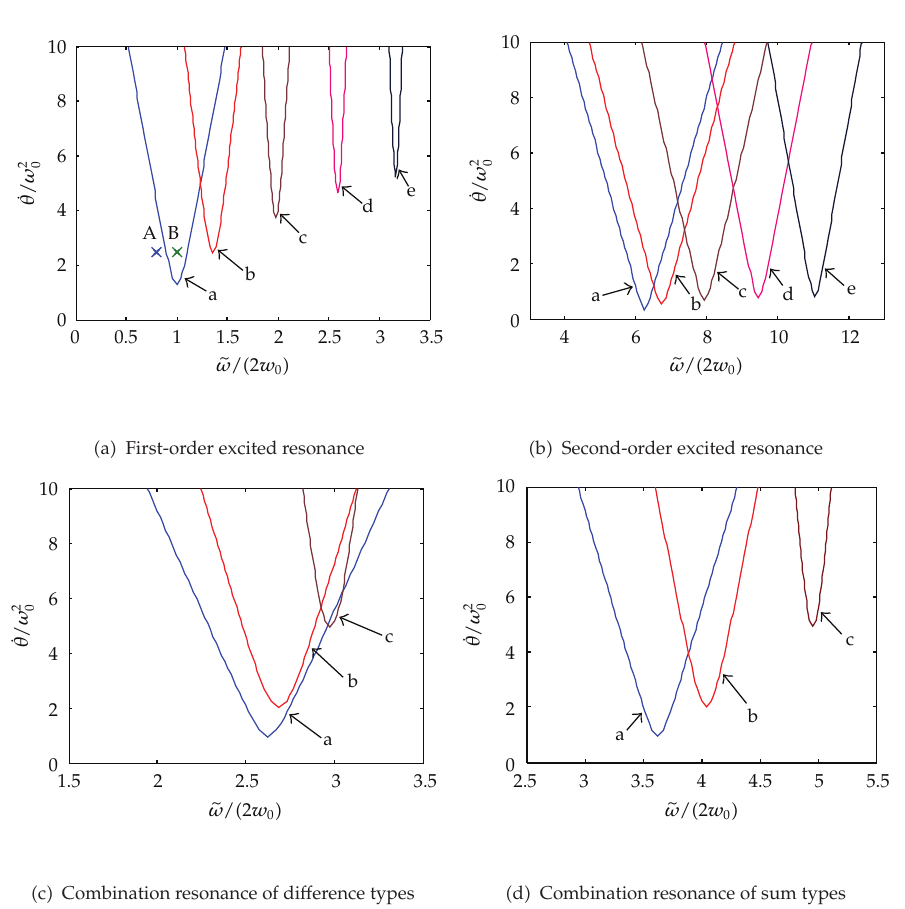
Figure 7: Instability boundaries for various applied electric fields: curve a, E (cid:8) 0kV/mm; curve b, E (cid:8) 0 . 5kV/mm; curve c, E (cid:8) 1 . 0kV/mm; curve d, E (cid:8) 1 . 5kV/mm; curve e, E (cid:8) 2kV/mm.